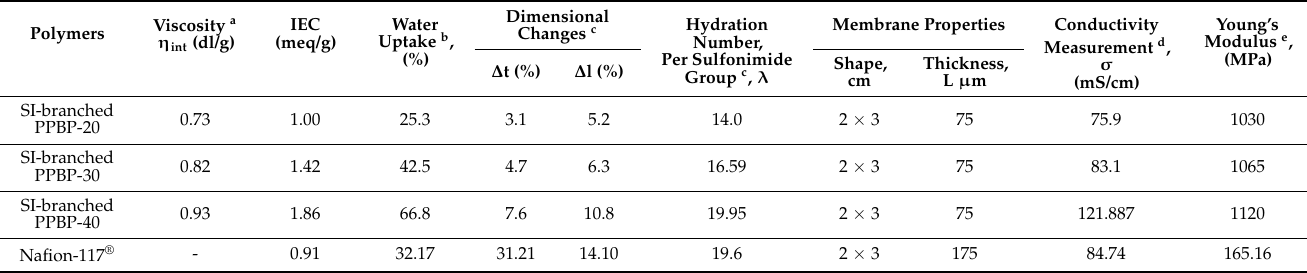
Table 1. Properties of membranes.